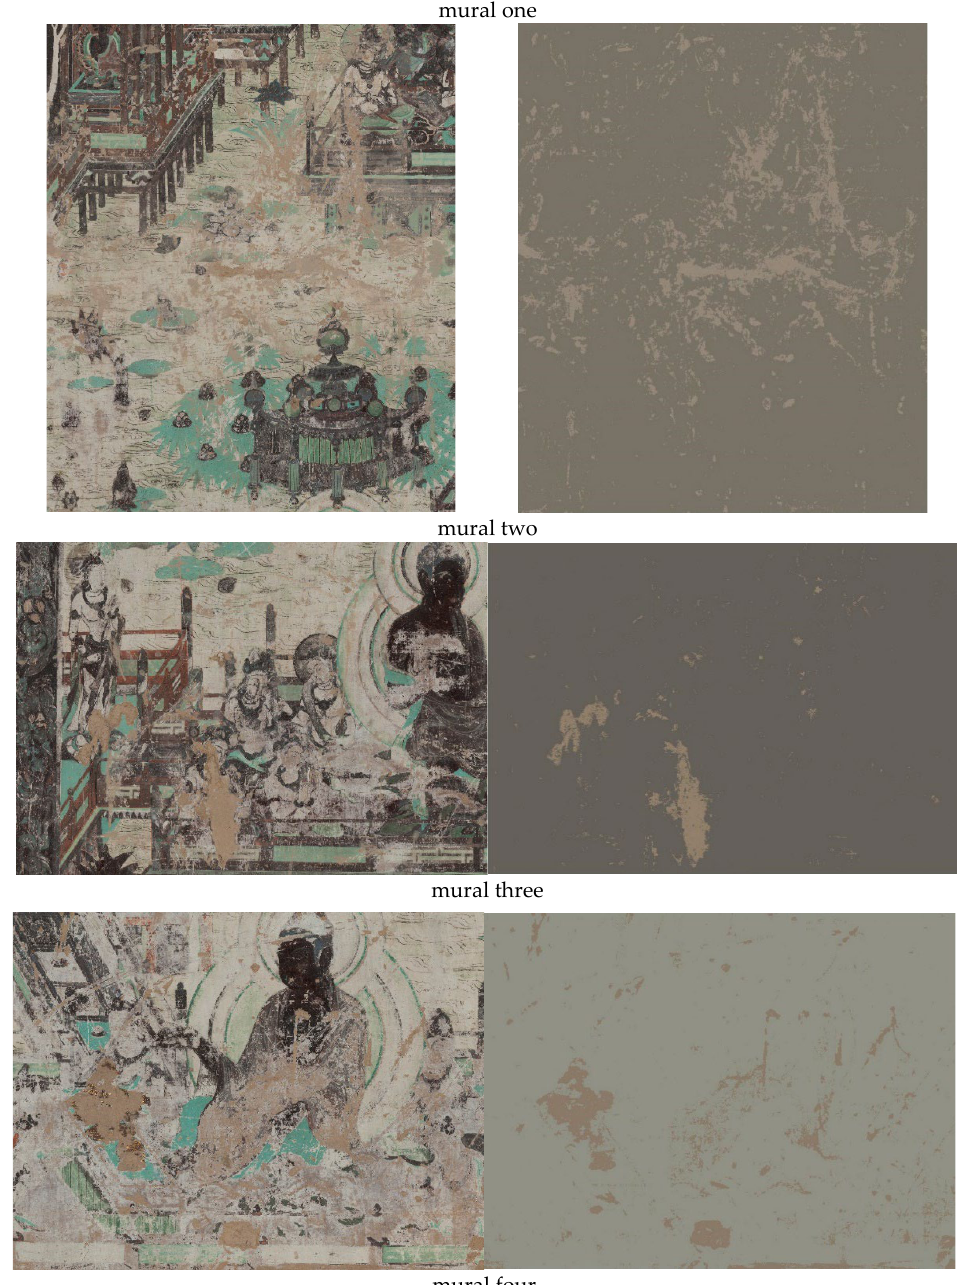
Figure 13. The four mural paintings of Mogao Caves and their outputs. Table 3 confirms that our proposed approach achieves a high extraction performance of 93%. Table 3. Classification summary and the number of extracted pixels after applying the MD approach of mural paintings of Mogao Caves.